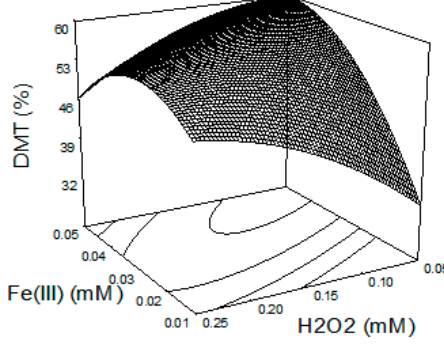
Figure 2. Effects of initial Fe 3+ and initial H 2 O 2 concentrations on DMT